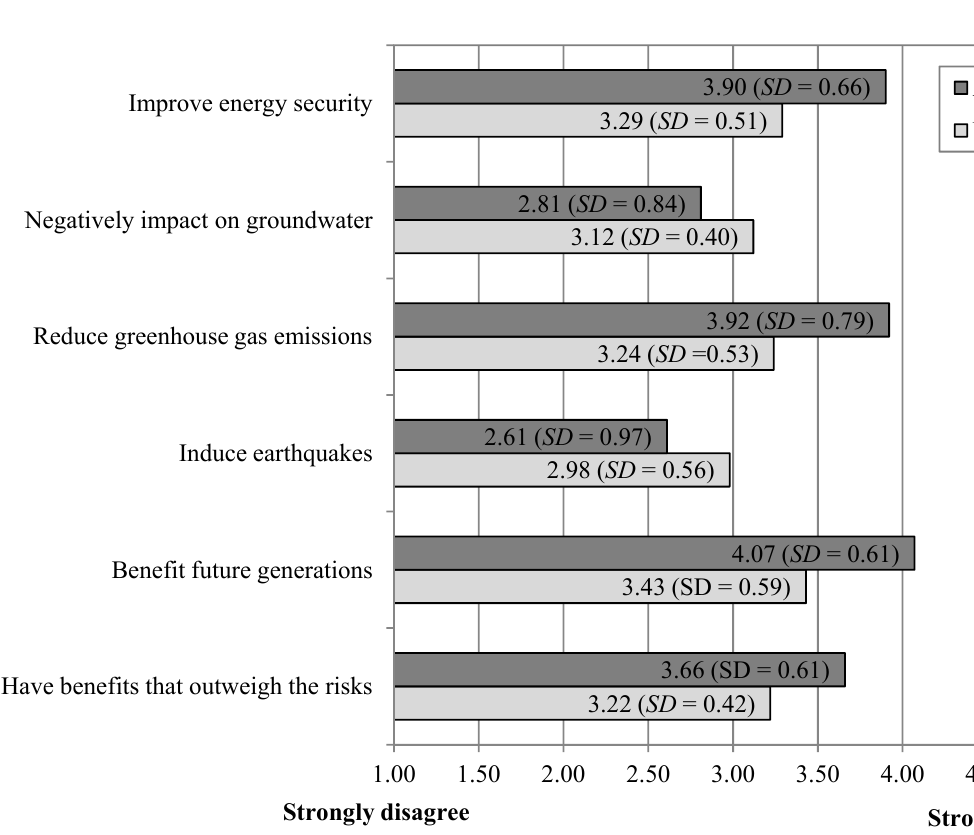
Figure 2. Mean ratings of benefits and risk by attitude group at the